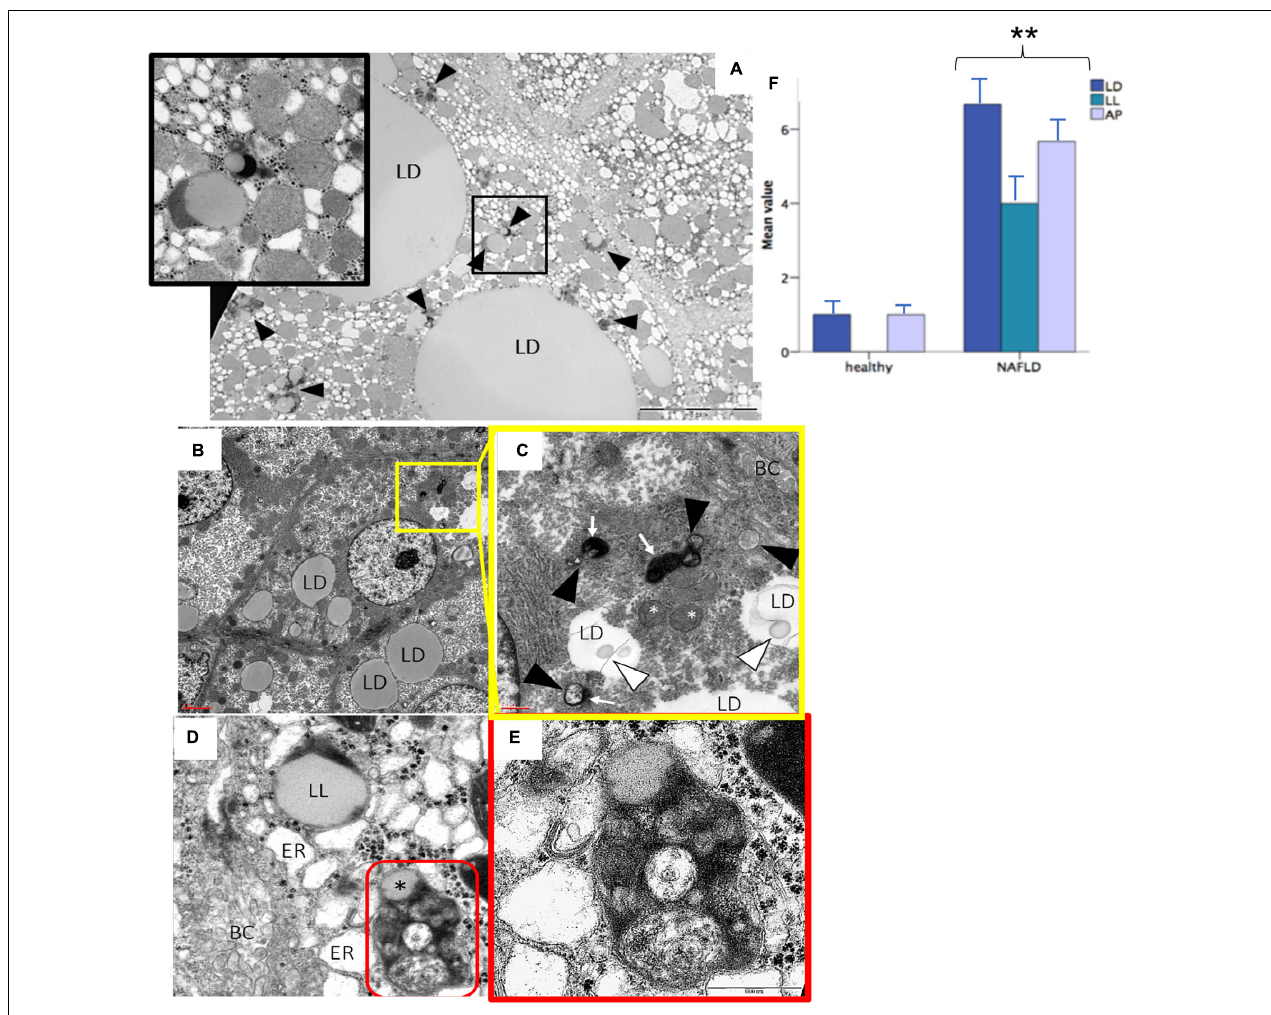
FIGURE 7 | Transmission electron microscopy analysis confirmed the presence of lipolysosomes with dense lipid core and typical electron-dense lysosomal membrane in fatty liver (A–D) . The different cellular organelles involved in the autophagic process phases are depicted in the high power fields (C,E) . Bars representing the number of autophagic organelles in NAFLD patients compared to healthy subjects (mean values, n = 5) (F) . LD, lipid droplet; LL, lipolysosome; AP, autophagosome; ER, stressed endoplasmic reticulum; BC, bile canaliculus; red circle, autolysosome; white arrowhead, phagophore; black arrowhead, immature autophagosome; white arrow, lysosome; white asterisk, stressed mitochondria; black asterisk, lipid component of autolysosome. Original magnification: 3900 × (A) ; 2300 × (B) ; 12000 × (C,D) ; 46000 × (E) . ** p <